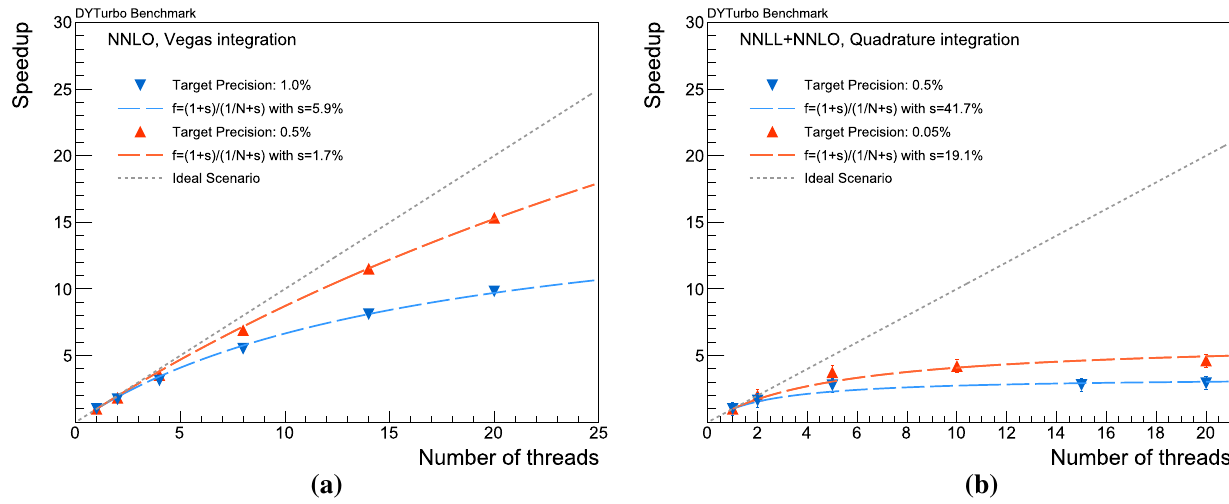
√ s = 8 TeV with different target precision: a NNLO